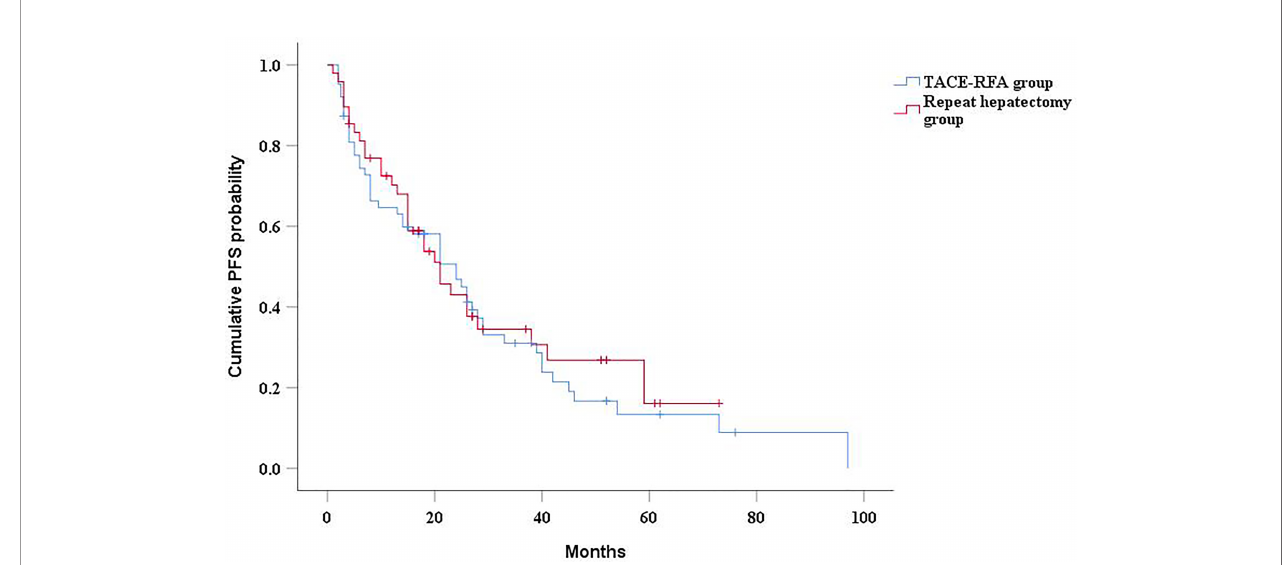
FIGURE 3 | Kaplan-Meier curves of PFS in recurrent HCC patients who received TACE-RFA or repeat hepatectomy.